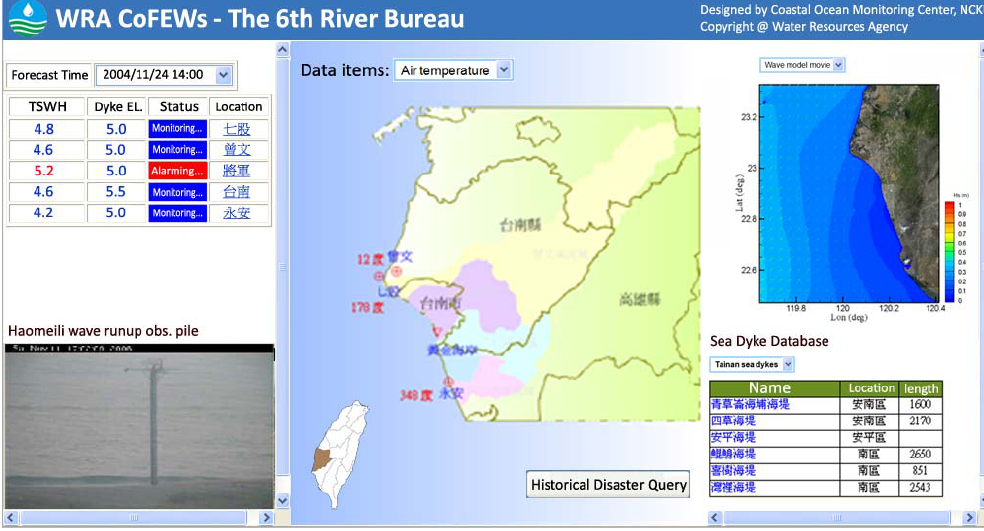
Figure 12 Main page of CoFEWs. Four parts are presented in this page. They are Real-time Sea States (RSS); Forecast Storm Level (FSL); Live Video Image (LVI); and Historical Typhoon Events (THE).